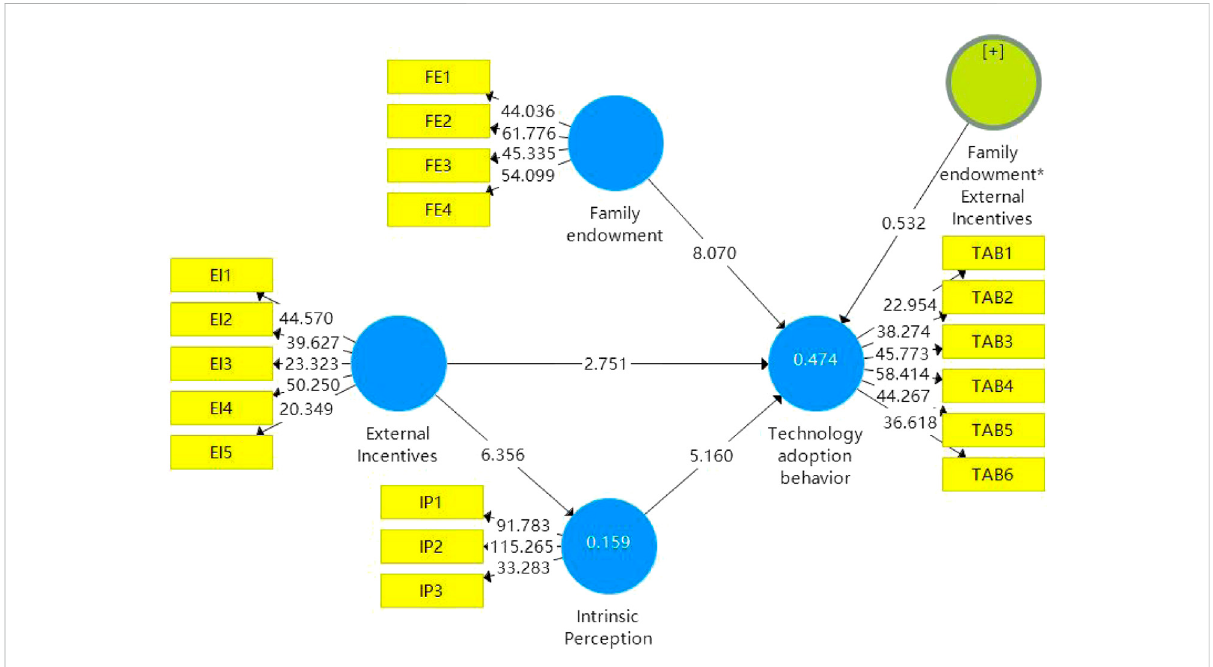
FIGURE 2 Model results